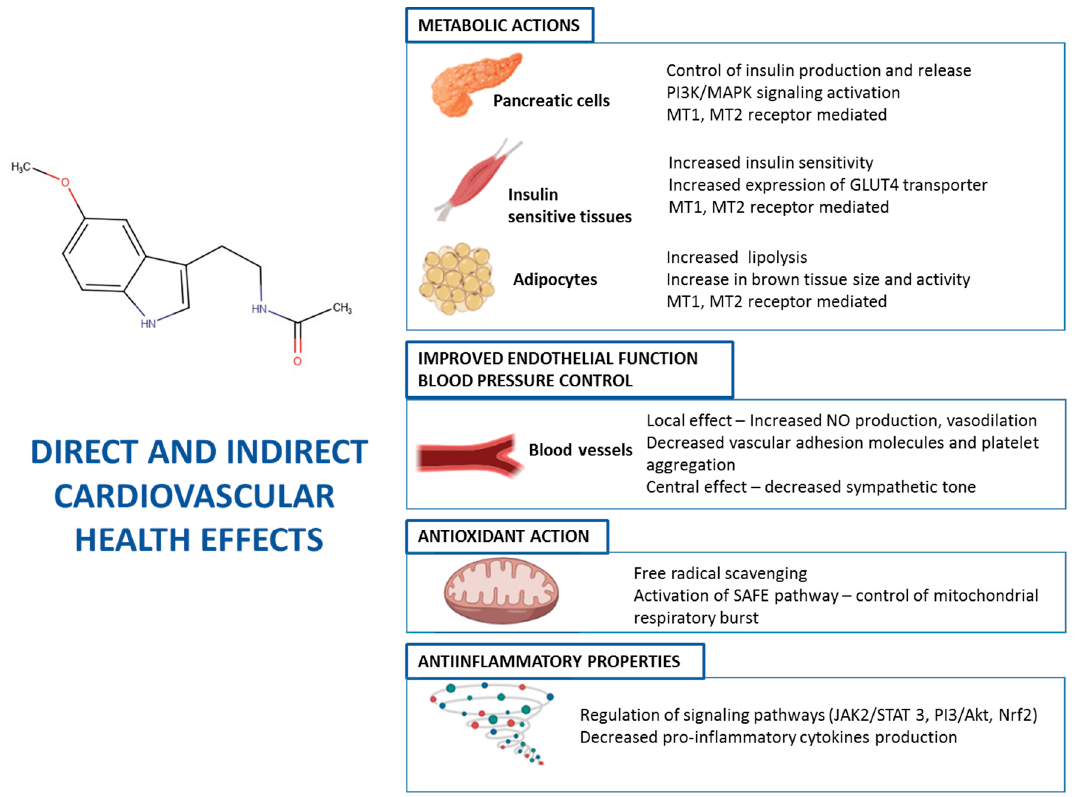
Figure 1. Mechanisms of action on MEL in different cells and tissues contributing to cardiovascular health.